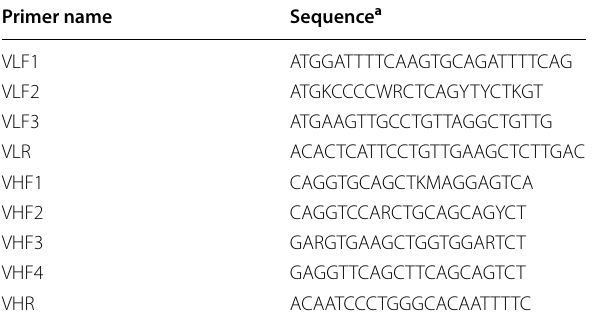
Table 1 Primers used in amplifying variable region sequences of mAb 1G8